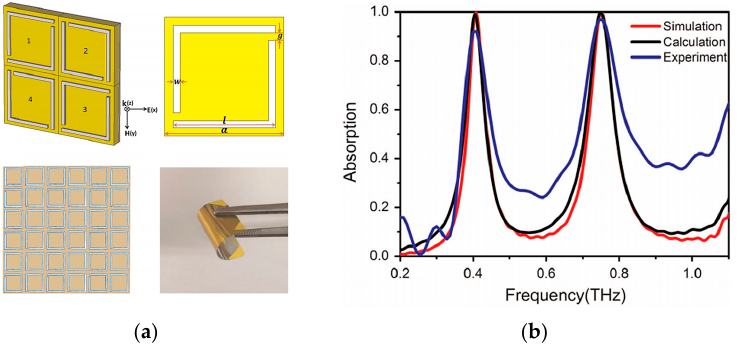
Figure 11. ( a ) Structure and ( b ) absorption curve of the ultra-thin flexible dual-band terahertz absorber [49].